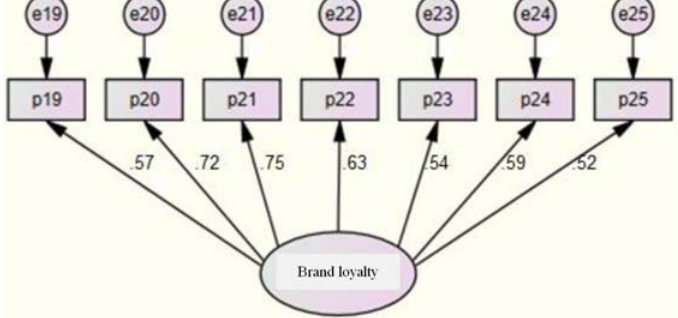
Fig. 4. First-order confirmatory factor analysis for brand loyalty